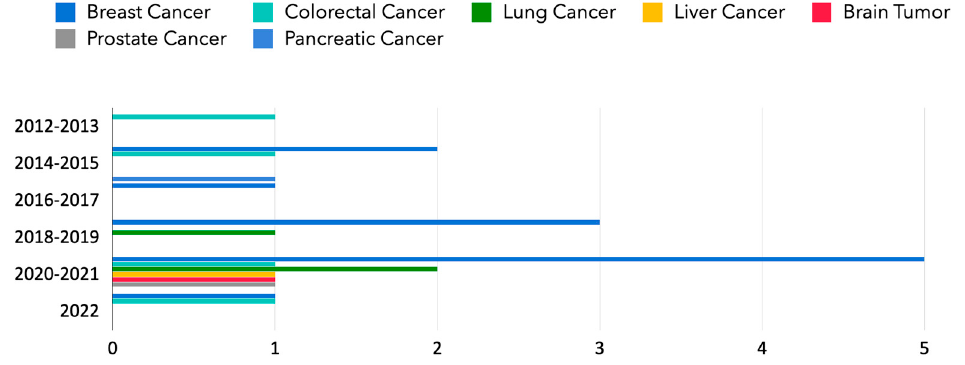
Figure 7. The evolution of different types of cancers over the years (2012–2022): a comparison of breast cancer, colorectal cancer, lung cancer, liver cancer, brain tumor, prostate cancer, and pancreatic cancer.